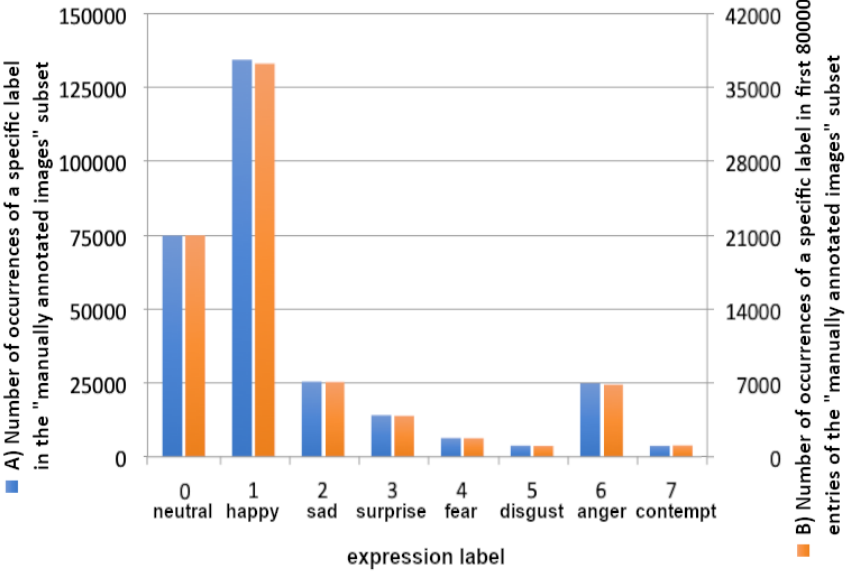
Figure 2. Training data distribution within the ‘manually annotated images’ subset (A, left, blue) of the AffectNet [20] Dataset and within its first 80,000 records only (B, right,